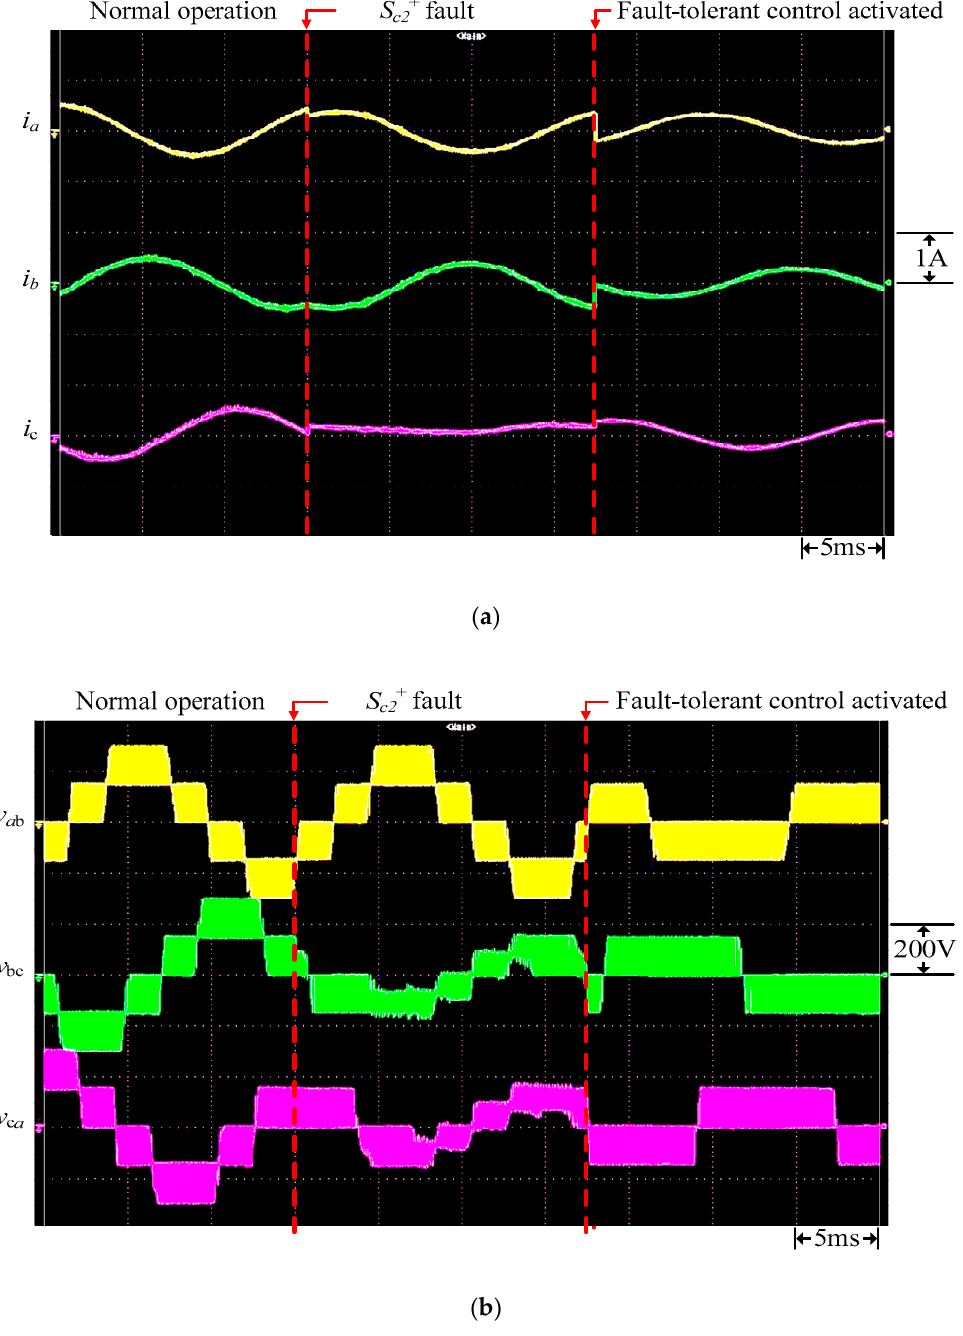
Figure 21. Measured waveforms of switch S c2 + with an open-circuit fault and tolerant control: ( a ) output line current; ( b ) output line voltage.